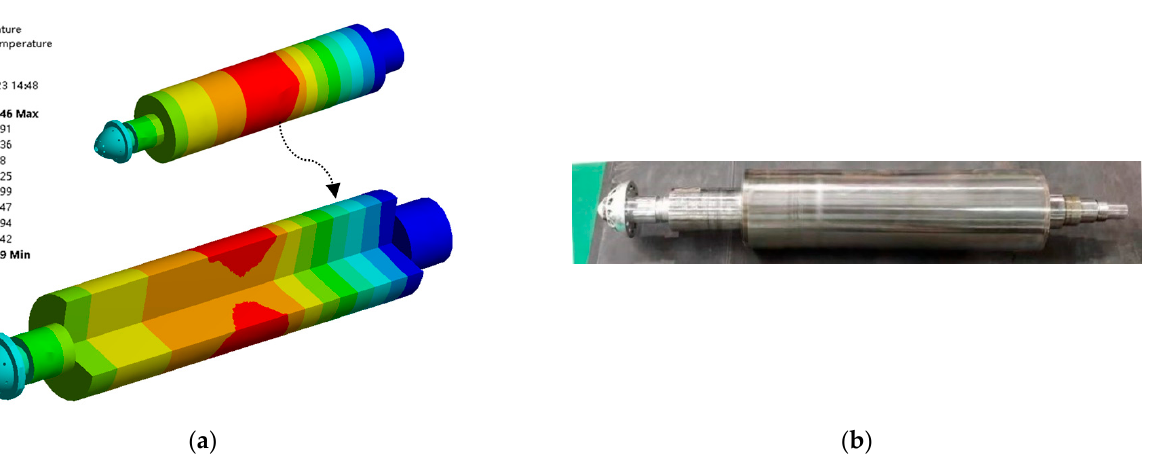
Figure 21. 3D thermal distribution and photo of the interior rotor: ( a ) Temperature distribution of the rotor at rated speed; ( b ) Zoomed-in photo of the interior rotor.